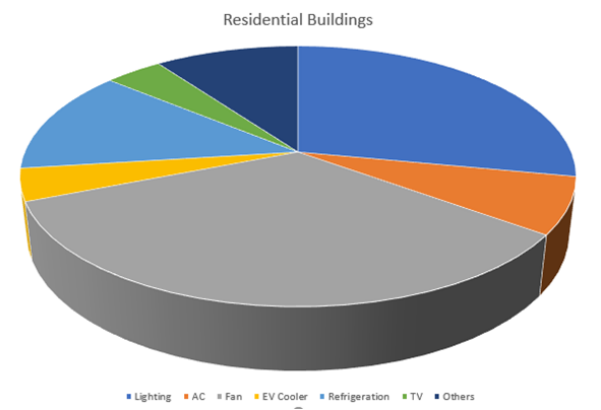
Fig.4 . Weather Info on Dashboard